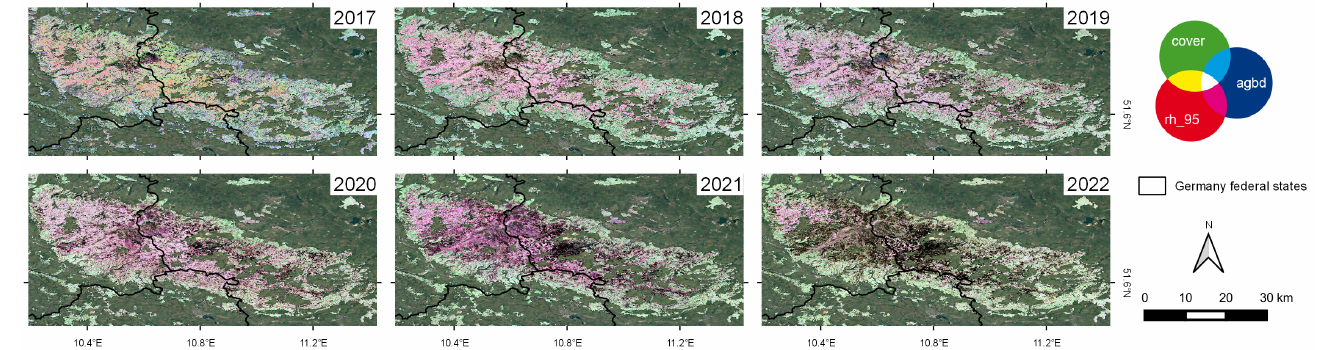
Figure 10. Forest structure change in the Harz region visualized as RGB image (red:rh_95, green:cover, blue:agbd). The visualization as RGB serves as combined visualization of canopy height, total canopy cover and AGBD as annual composites to emphasize the asynchronous temporal dynamics in forest structure. Before stacking the layers, each attribute of forest structure was rescaled to values from 0 to 255 so that the attributes can be compared visually, i.e., to remove scale-dependency. Light colors present high values for all forest structure attributes (e.g., 2017) compared to dark colors (e.g., 2022) which represent low values in the attributes of forest structure. The dominance of a single color (e.g., red in 2018–2021) in large areas highlights comparably high values in canopy height, i.e., losses in total canopy cover and AGBD. The presence of black areas in 2022 presents low overall forest structure, i.e., low canopy height, total canopy cover and